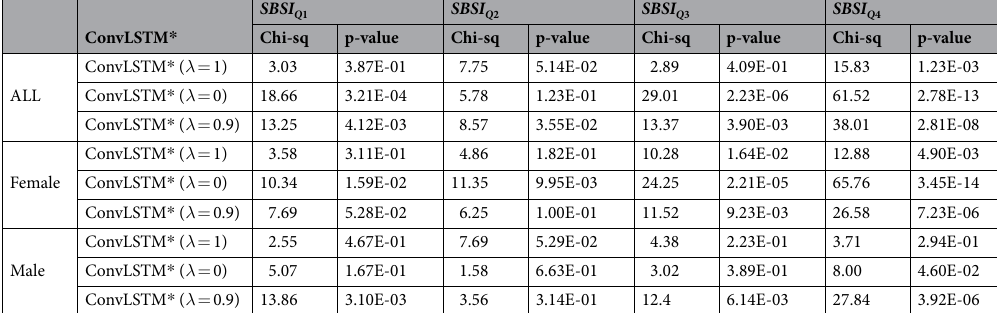
for different WHtR CA